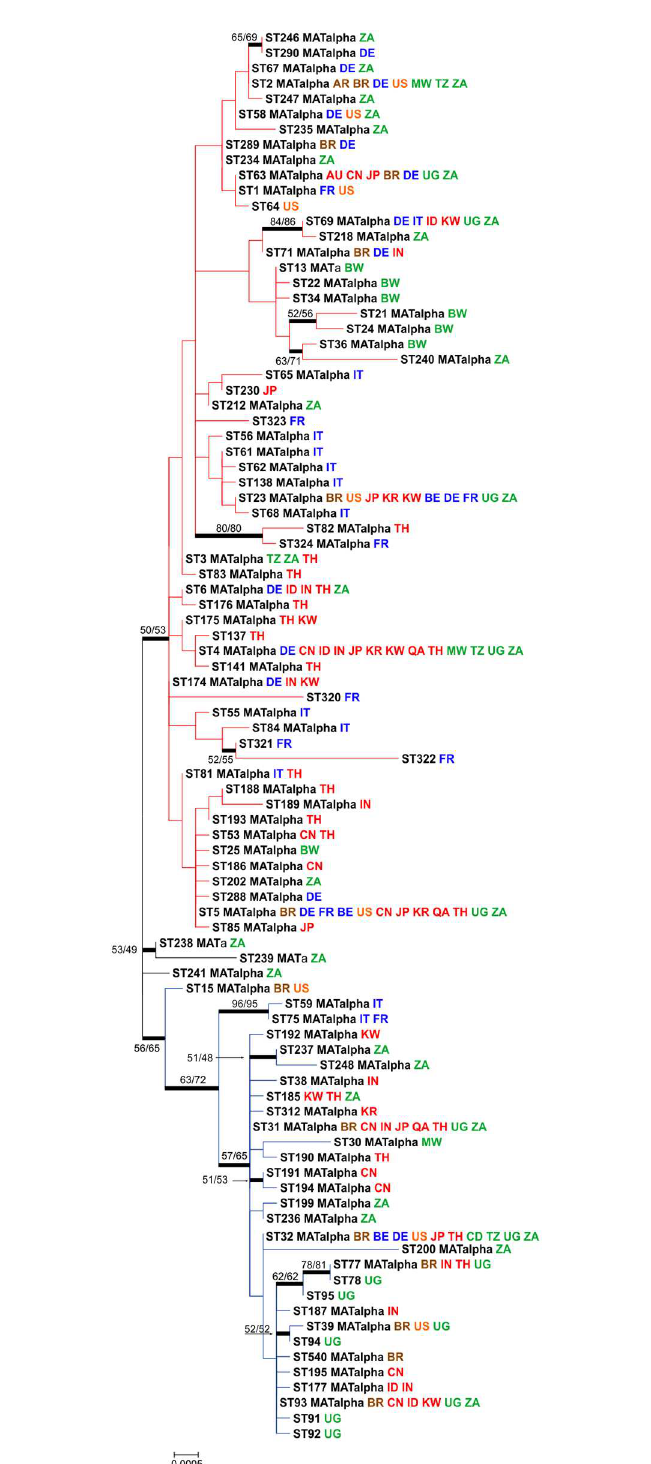
Fig 2. Maximum likelihood (ML) consensus tree of the global Cryptococcus neoformans var. grubii VNI dataset using the concatenated sequences of the seven MLST loci ( CAP59 , GPD1 , LAC1 , PLB1 , SOD1 , URA5 , and the IGS1 region). The tree with the highest log likelihood (-7,114) drawn to scale with branchlengths measuring the numberof substitutionsper site is shown. Bootstrap values > 50% basedon 1,000 replicates for the ML and the neighbour-joining(NJ) analyses, which showedsimilar topologies,